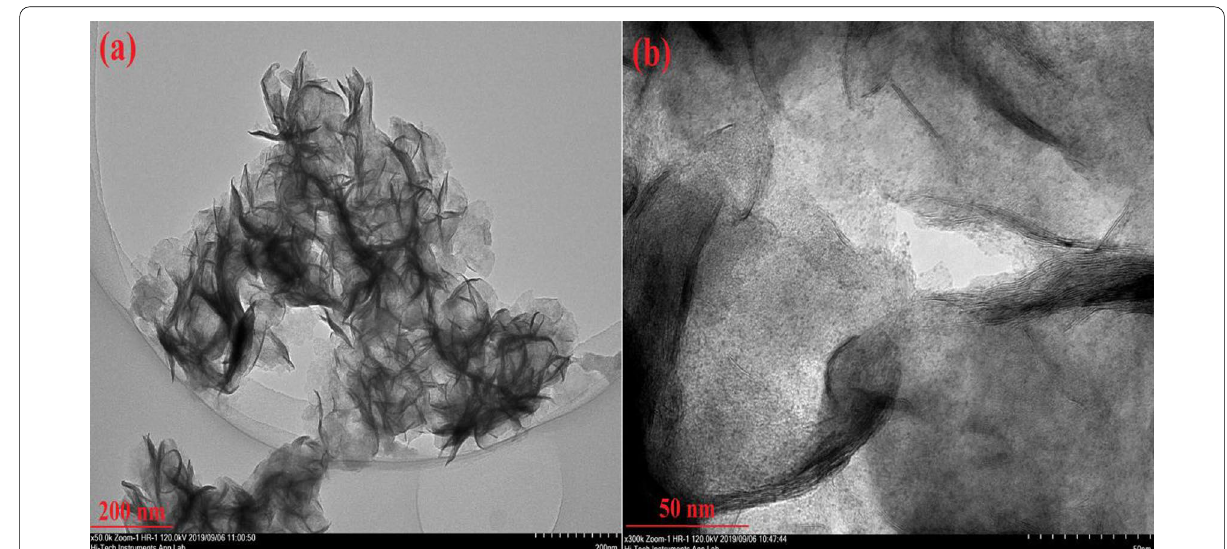
Fig. 4 a , b TEM image of Pt/Mo-90 composite